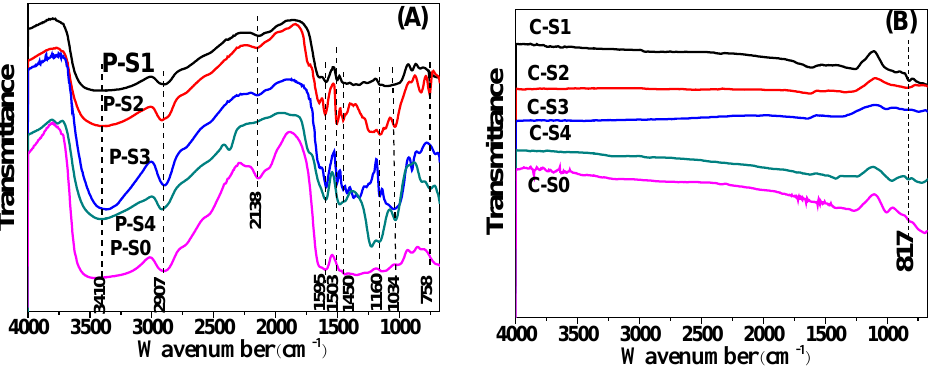
Figure 5. Fourier-transform infrared (FT-IR) spectra of ( A ) bamboo charcoal-based composites precursors of P-S1, P-S2, P-S3, P-S4, and P-S0; and ( B ) bamboo charcoal/TiO 2 composites of C-S1, C-S2, C-S3, C-S4, and C-S0.